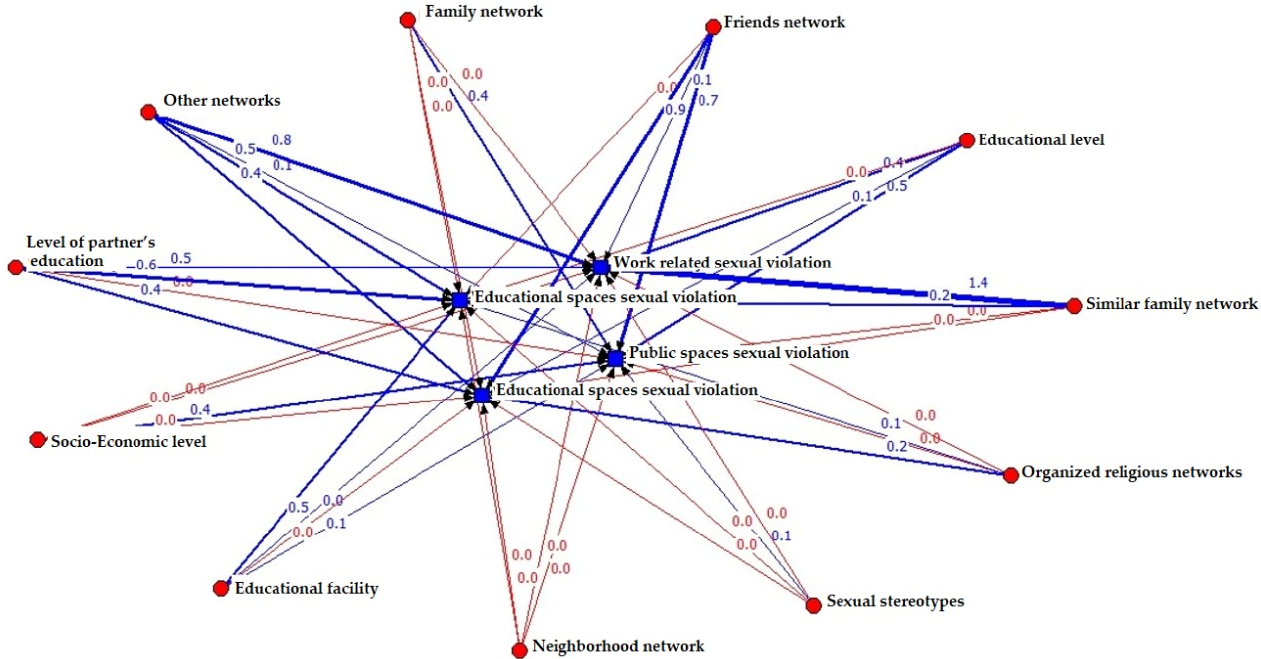
Figure 1. Neural network (result) between factors (social, economic and human capital) and areas of sexual violence. (Note: for graphic purposes, negative values are represented with a value of 0.0 and with a red line). Table 4. Average coefficients between factors (types of capital) and areas of sexual